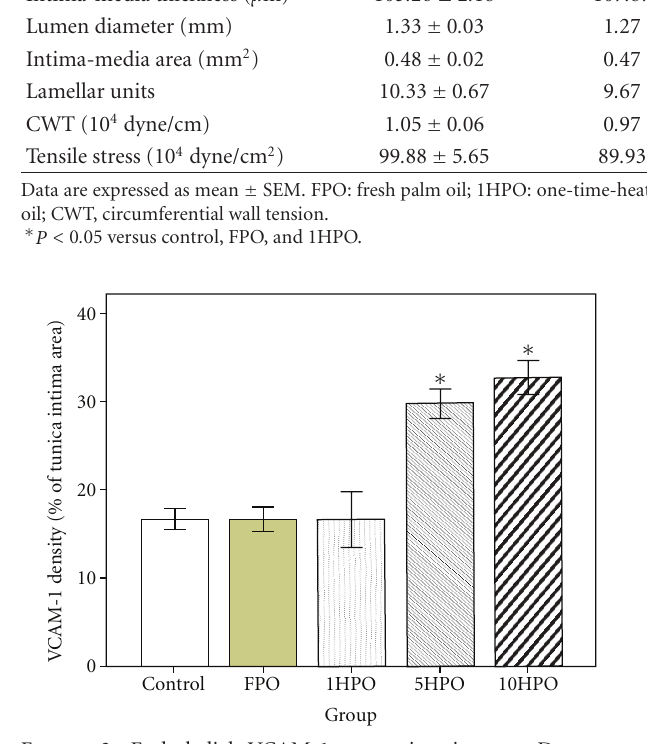
Figure 3: Endothelial VCAM-1 expression in rats. Data are expressed as mean ± SEM. FPO, fresh palm oil; 1HPO, one-time- heated palm oil; 5HPO, five-time-heated palm oil; 10HPO, ten- time-heated palm oil. ∗ P < 0 . 05 versus control, FPO, and